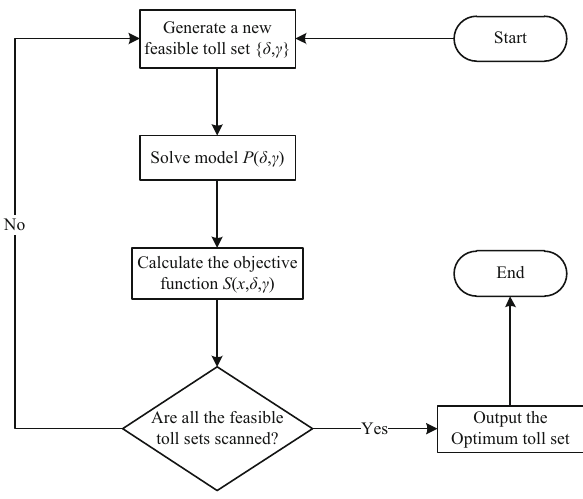
Fig. 3 Flowchart of the applied enumeration